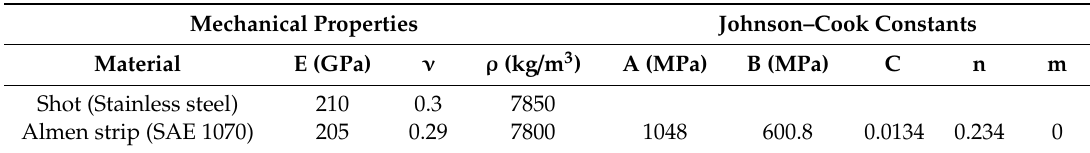
Table 1. Mechanical properties and Johnson–Cook constants of the Almen strip (taken from Jebahi and Gakwaya